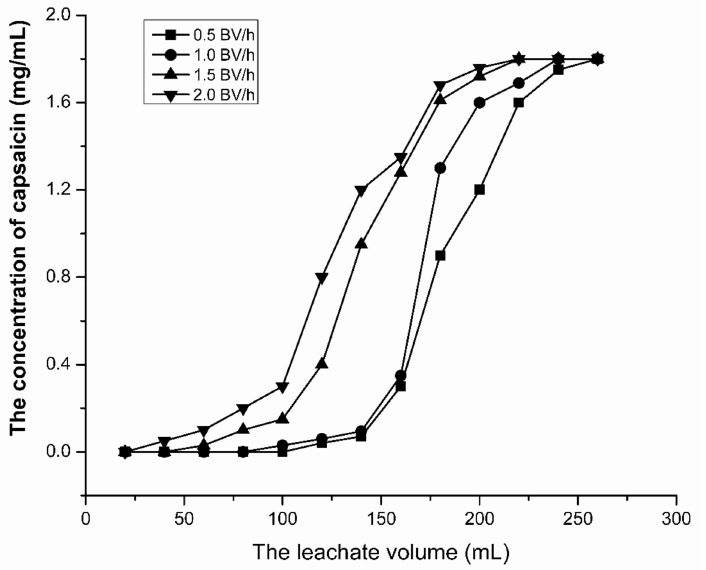
Figure 5. E ff ect of the sample loading flow-rate on the adsorption capacity of the SKP-10-4300